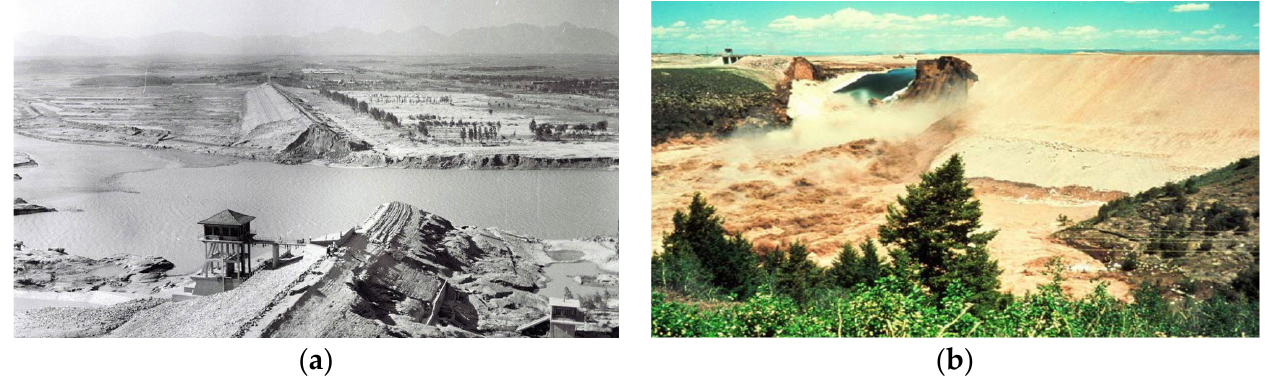
Figure 1. Major dam failures in the world. ( a ) Collapse of Banqiao Dam in China; ( b ) Teton Dam Breach in US.